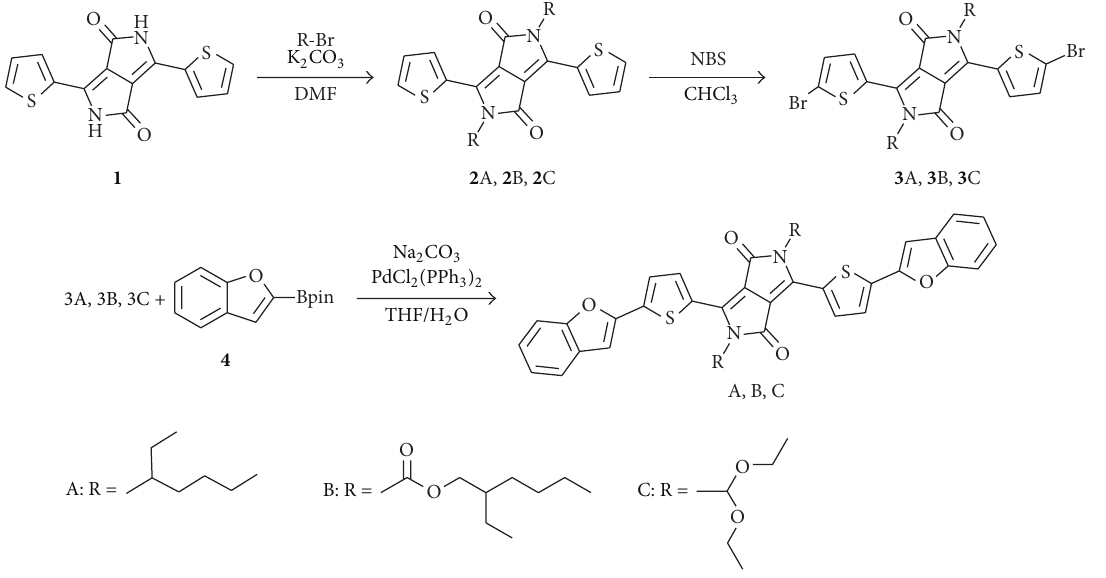
Figure 2: Reaction